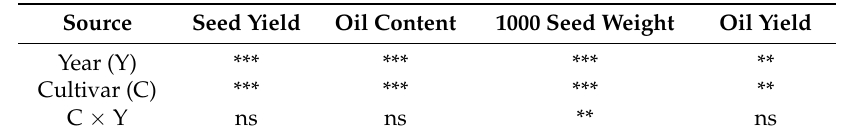
Table 5. Statistical significance (ANOVA) of year and cultivar effects on some traits in plants with inflorescence removed.